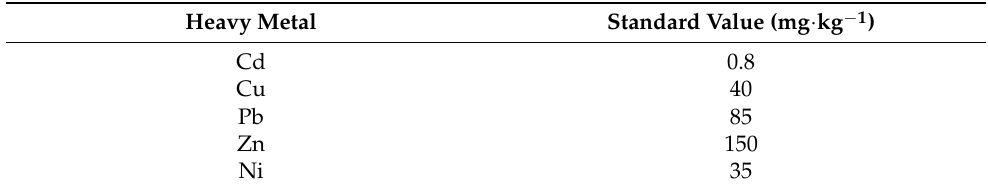
Table 5. Standard value of each heavy metal concentration in the sediment according to the Romanian Order 161/2006